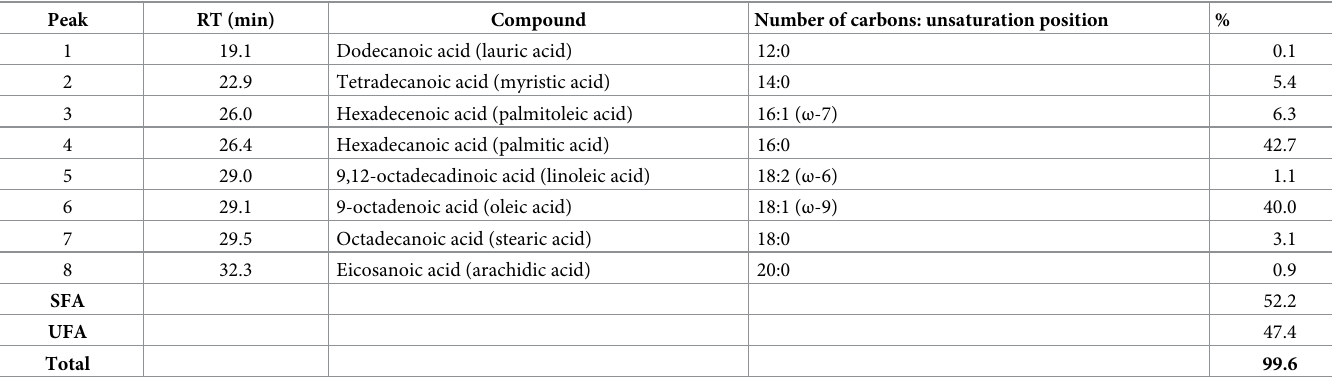
Table 1. Fatty acids identified in the RPLO.